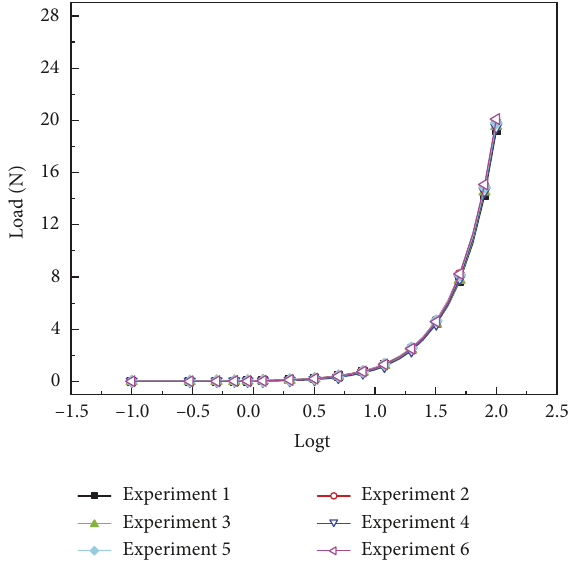
Figure 4: The load-time curve at the same speed.